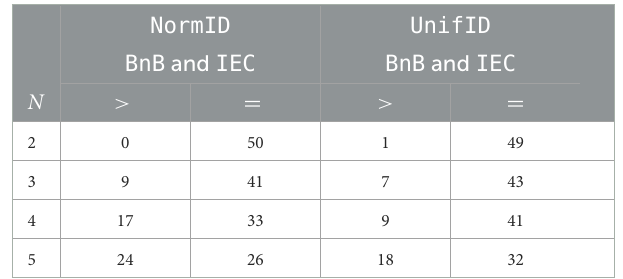
TABLE 4 Objective values comparison with BnB and IEC for UnifID and NormID